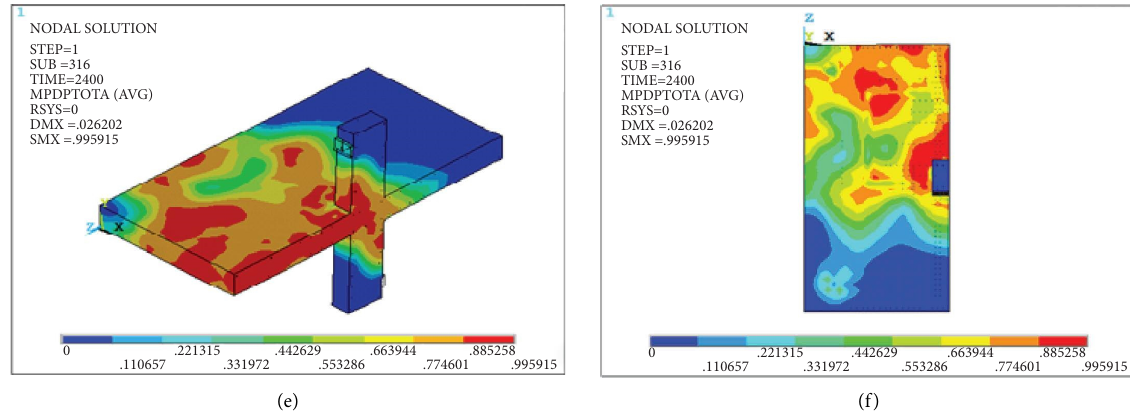
Figure 41: Concrete damage of specimens with varying fre exposed surface. (a) Specimen 200-45-1-ALL TS-2400. (b) Bottom surface. (c) Specimen 200-45-1-Half TS-2400. (d) Bottom surface. (e) Specimen 200-45-1-Half BS-2400. (f) Bottom surface.